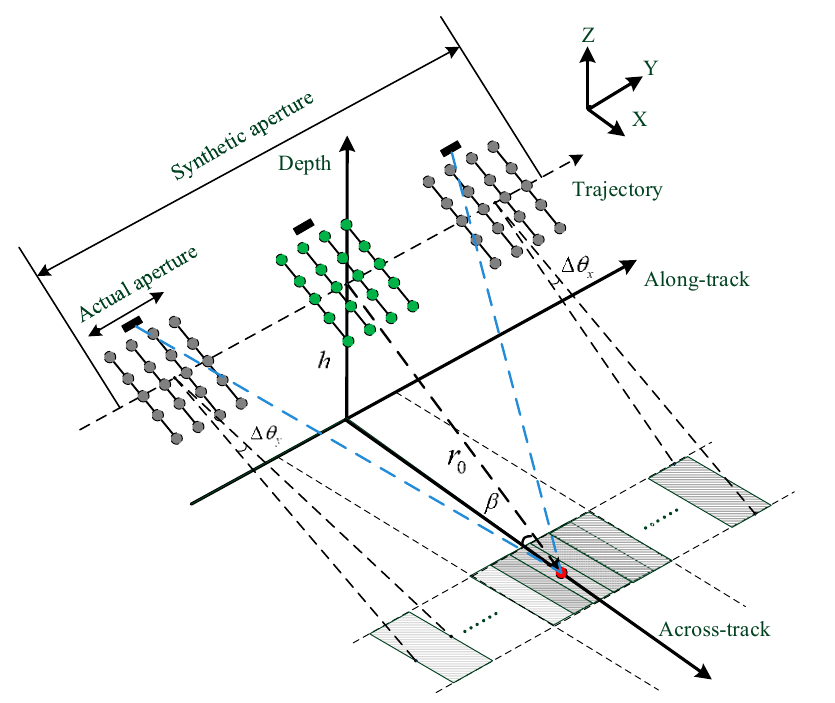
Figure 1. 2D transducer array and echo model of MBSAS.